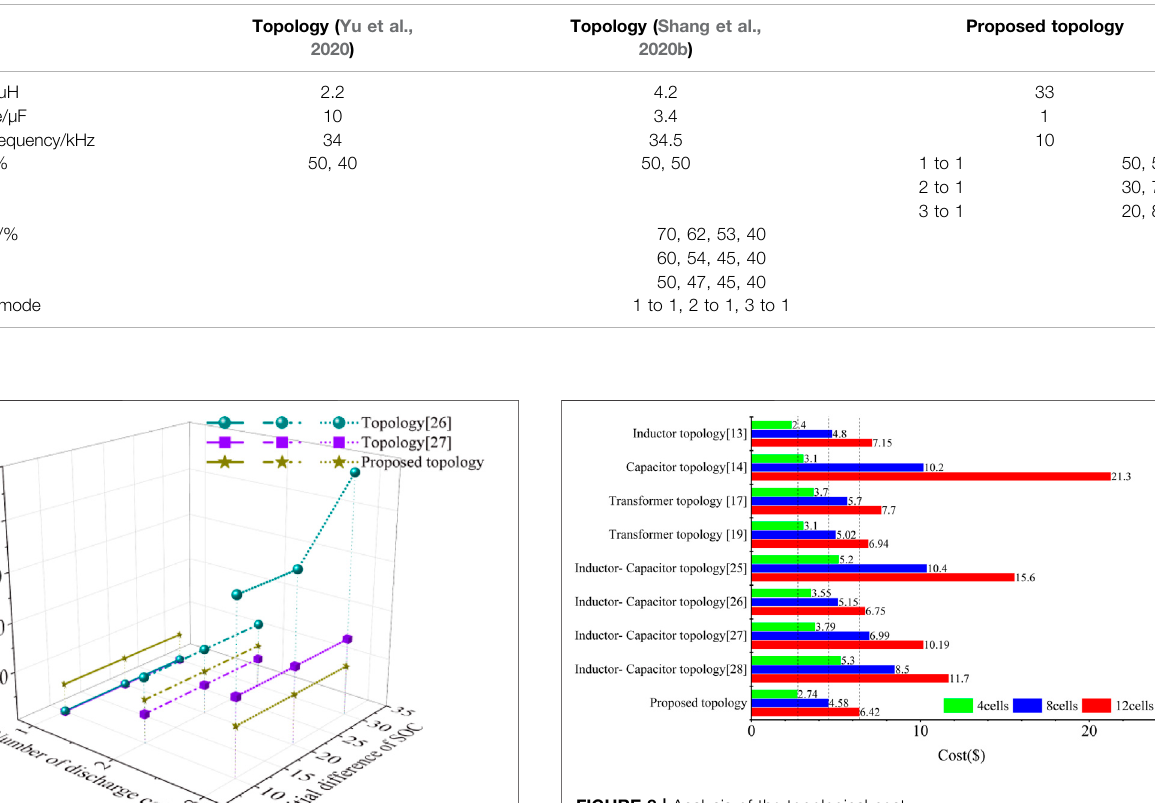
FIGURE 8 | Analysis of the topological